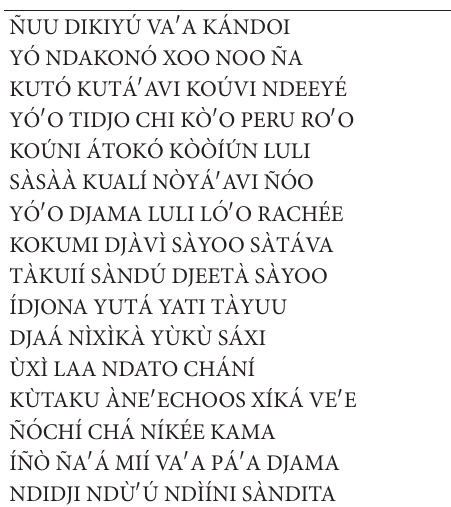
Table 4: Adaptation stimuli